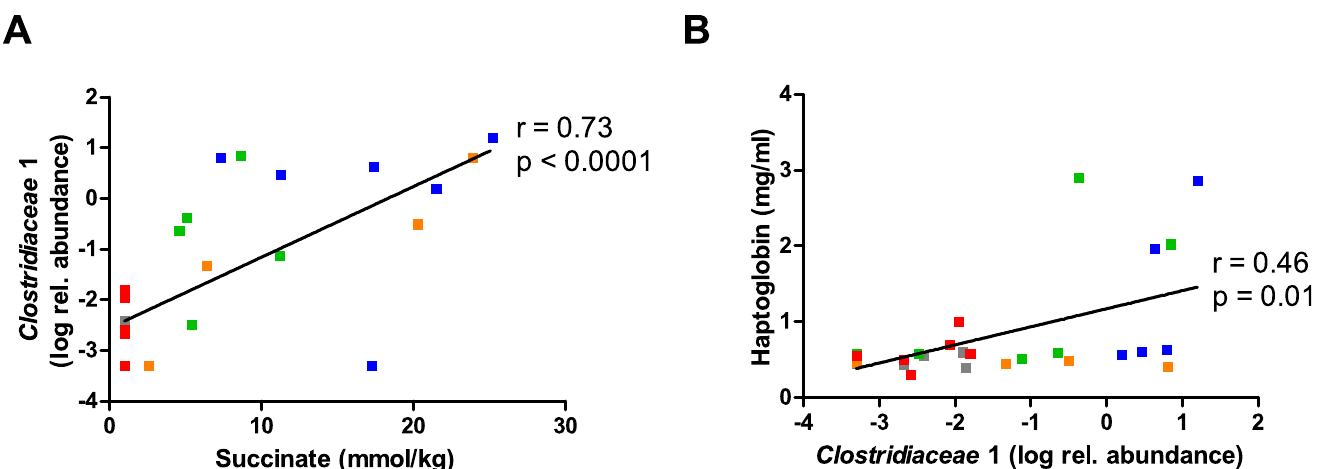
Fig 7. Correlation analysis. (A) Spearman correlation between succinate and the relative abundance of Clostridiaceae 1 family and (B) between the relative abundance of Clostridiaceae 1 family and plasma haptoglobin levels. Each dot represents individual animals within the CON, control (grey); AMX, amoxicillin (blue); CTX, cefotaxime (green); VAN, vancomycin (yellow); MTZ, Metronidazole (red) groups and lines show the linear regression. Spearman r and P values are